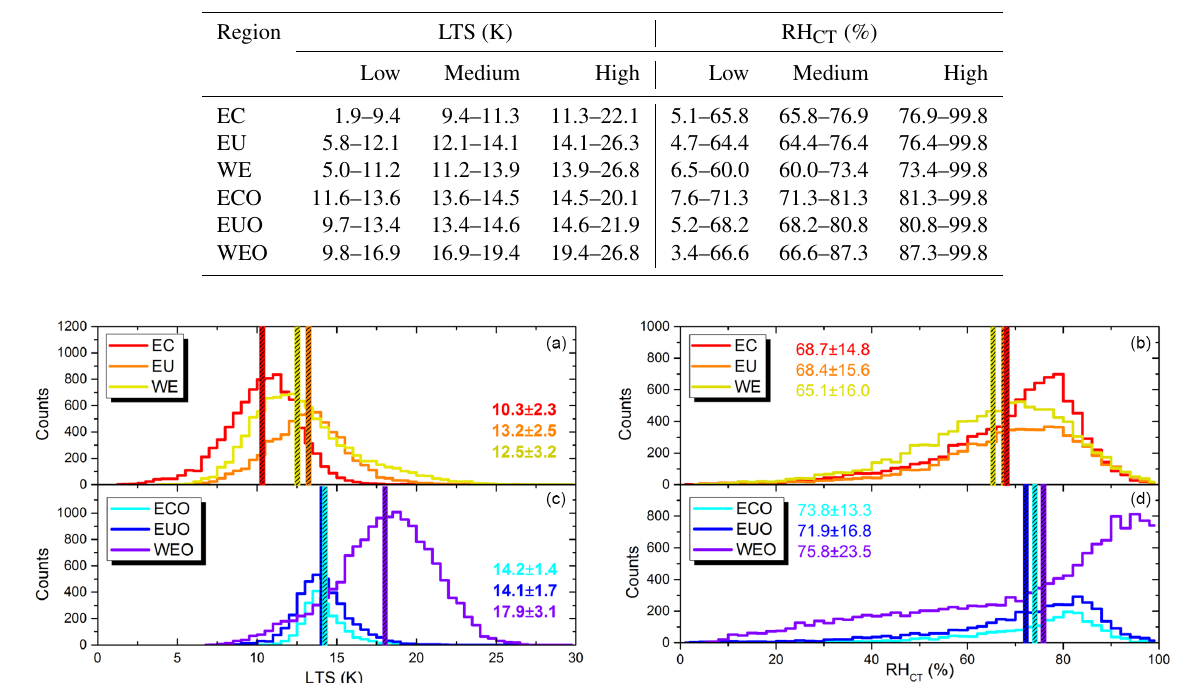
Figure 10. The distributions of sample number for (a, c) LTS and (b, d) RH CT over land ( a, b ; EC, EU, and WE) and ocean ( c, d ; ECO, EUO, and WEO). Vertical lines show the mean values. Texts with the corresponding color represent the mean and standard deviation for each